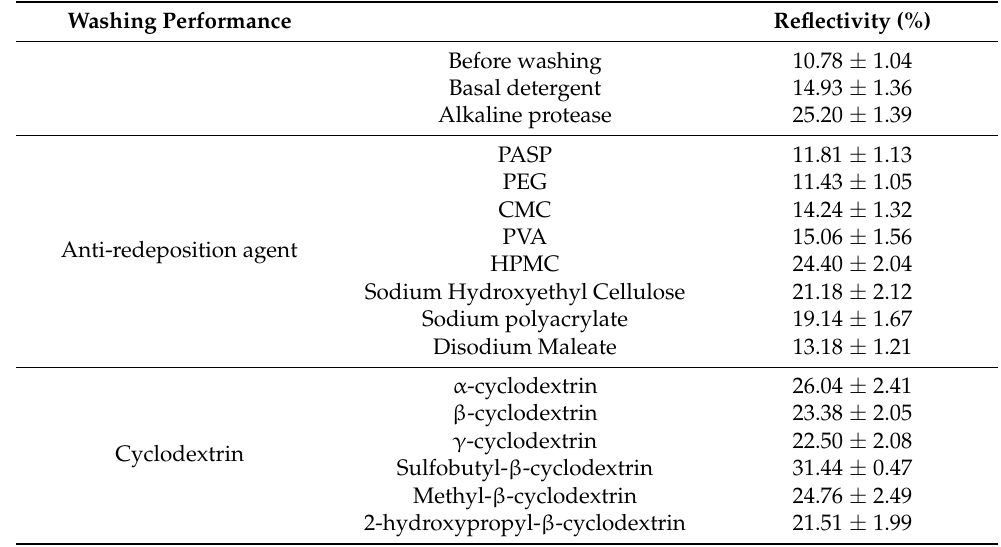
Table 3. Washing effect of anti-redeposition agent mixed with alkaline protease on blood dirty